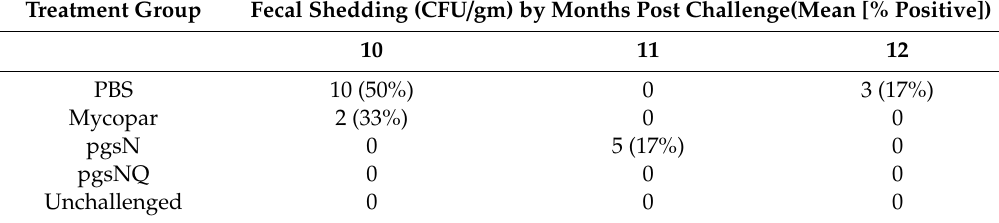
Table 1. M. paratuberculosis challenge strain fecal